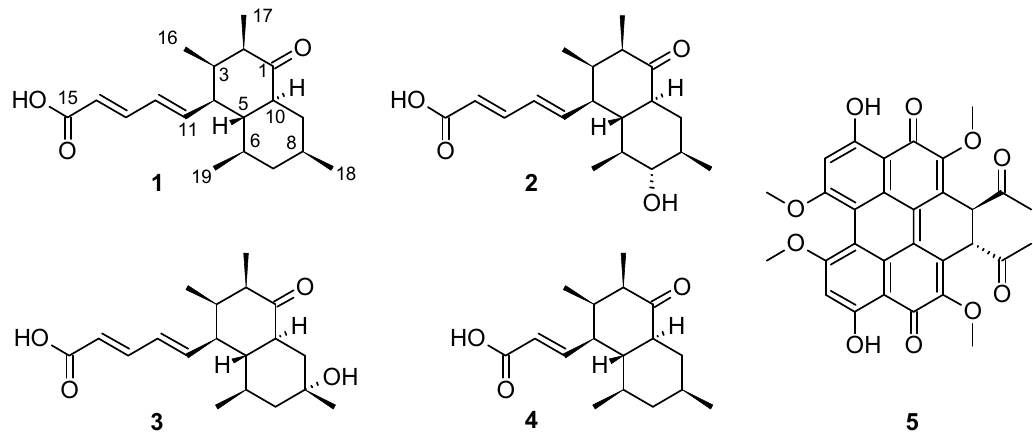
Figure 1. Structures of the secondary metabolites isolated from Elsino ё piri strain 2203C.